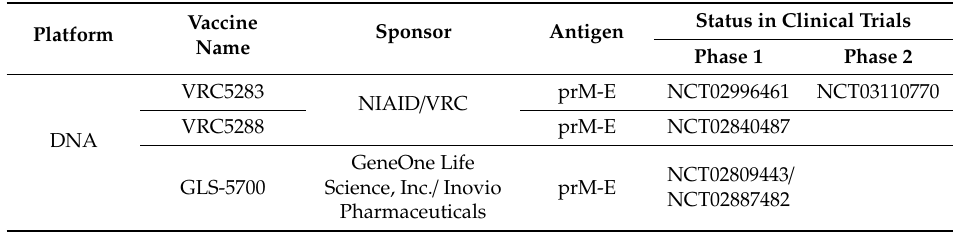
Table 1. ZIKV vaccine candidates and their status in clinical